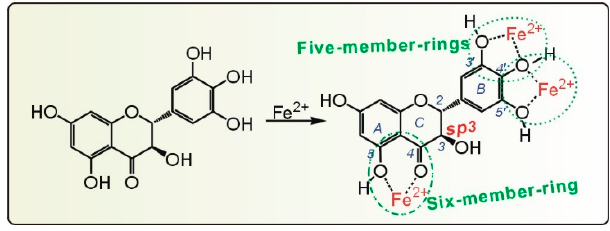
Figure 9. The proposed chelation of Fe 2+ by dihydromyricetin (DHM).